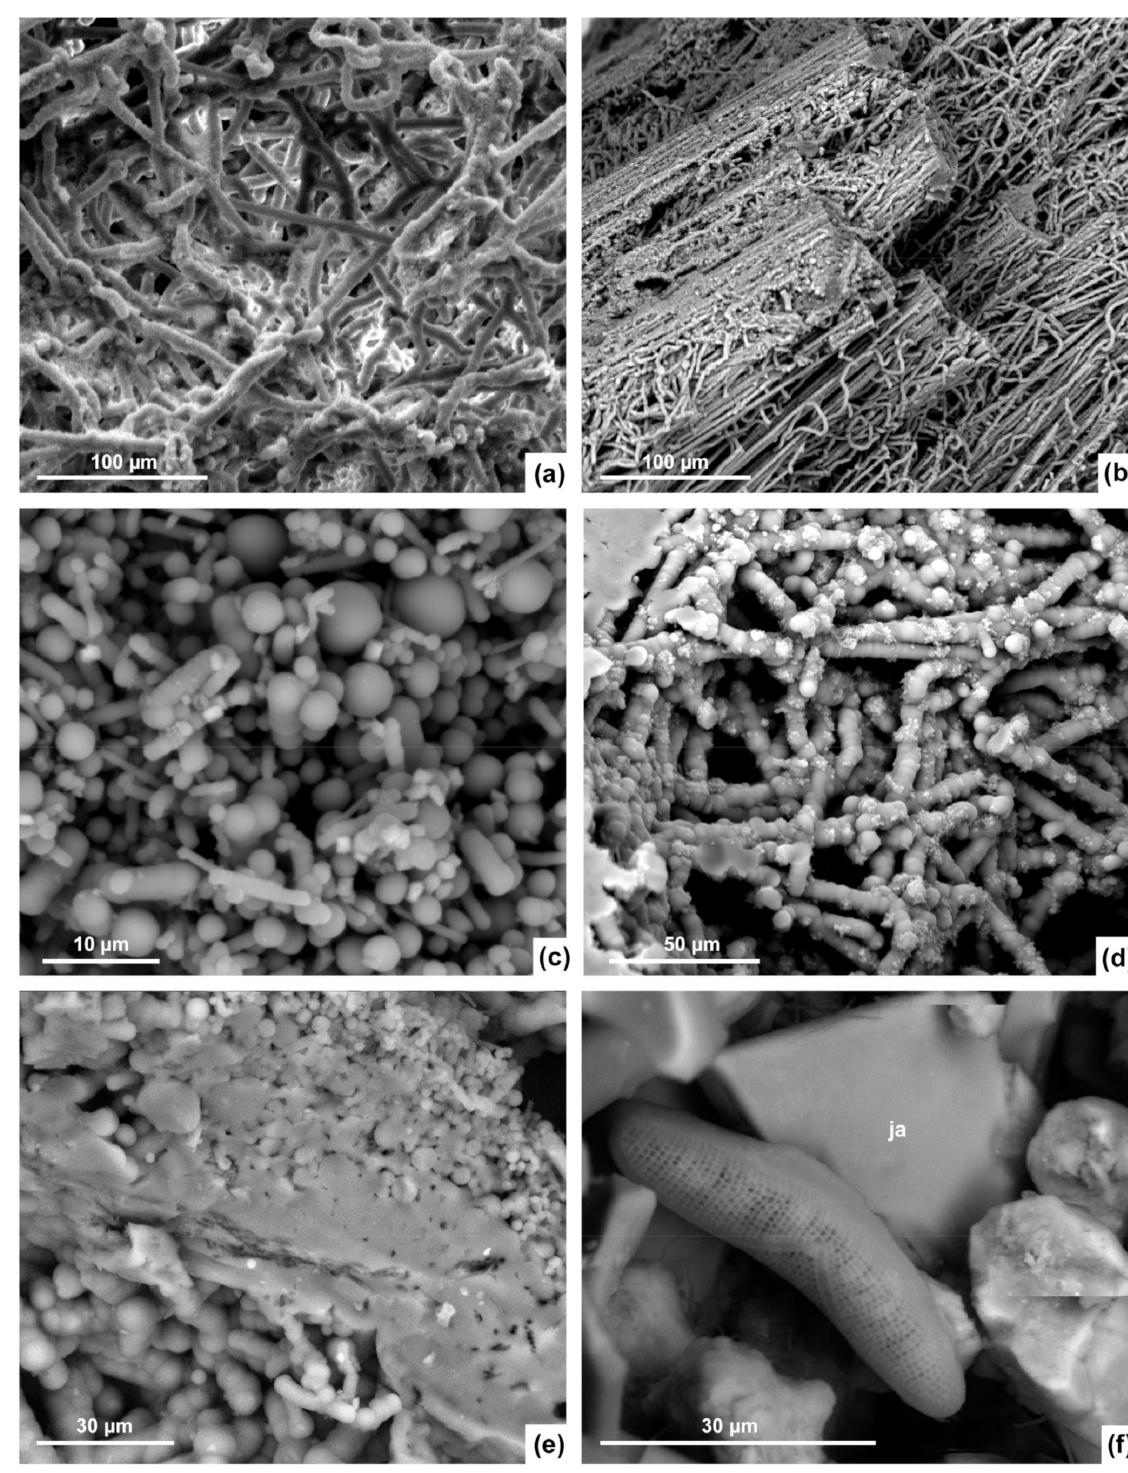
Figure 5. Environmental scanning electron microscopy (ESEM) images of Selt ú n sinter exhibiting 3D textures. ( a ) Sparsely packed meshwork of chaotically arranged microbial filaments forming highly porous growth frameworks. ( b ) Densely interwoven, flat-lying filaments, forming packets about 50 µ m thick. ( c ) Clusters of densely packed rod-shaped and coccoids forming porous growth frameworks. ( d ) Loose interwoven filament bundles. ( e ) Silica crust showing agglomeration of opal spheres. ( f ) Diatom embedded in a microbial network including jarosite rhombohedral crystals